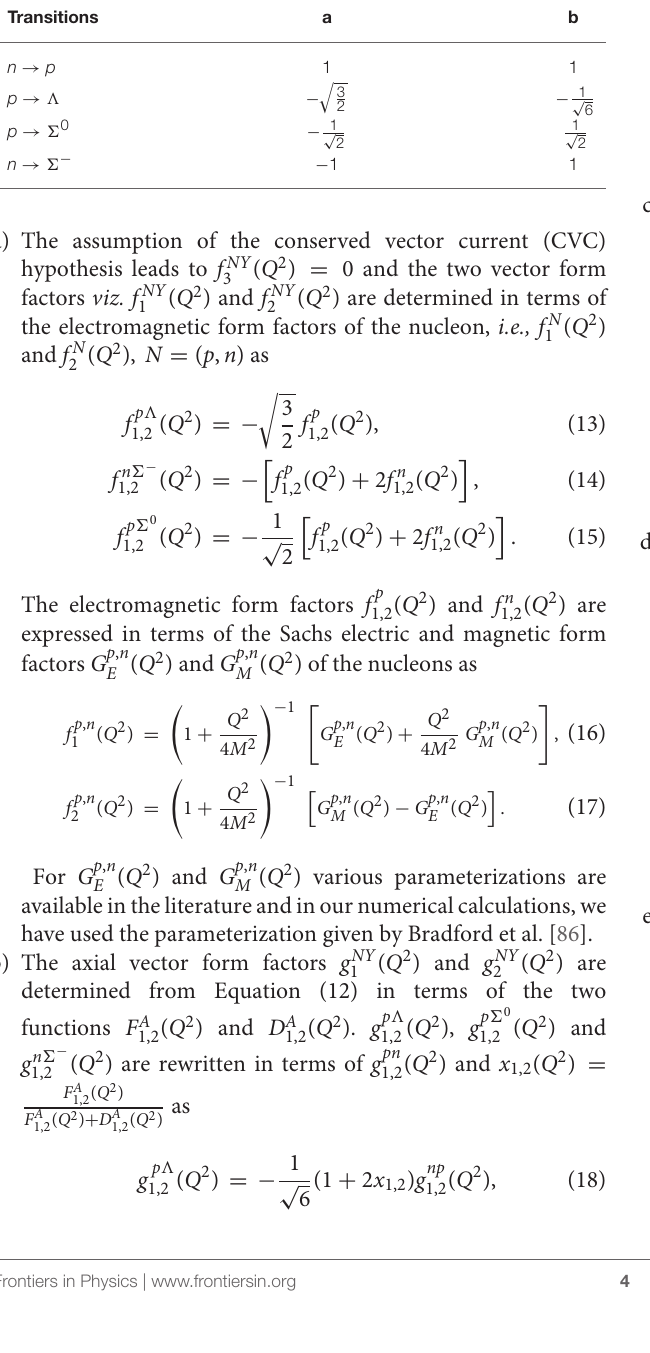
TABLE 1 | Values of the coefficients a and b given in Equations (11),(12). Transitions a b n p →